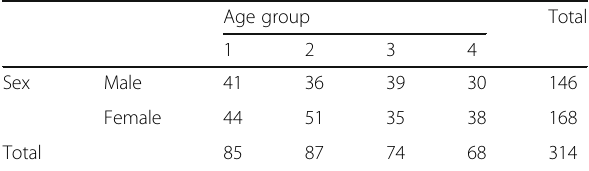
Table 1 Number of men and women in each age